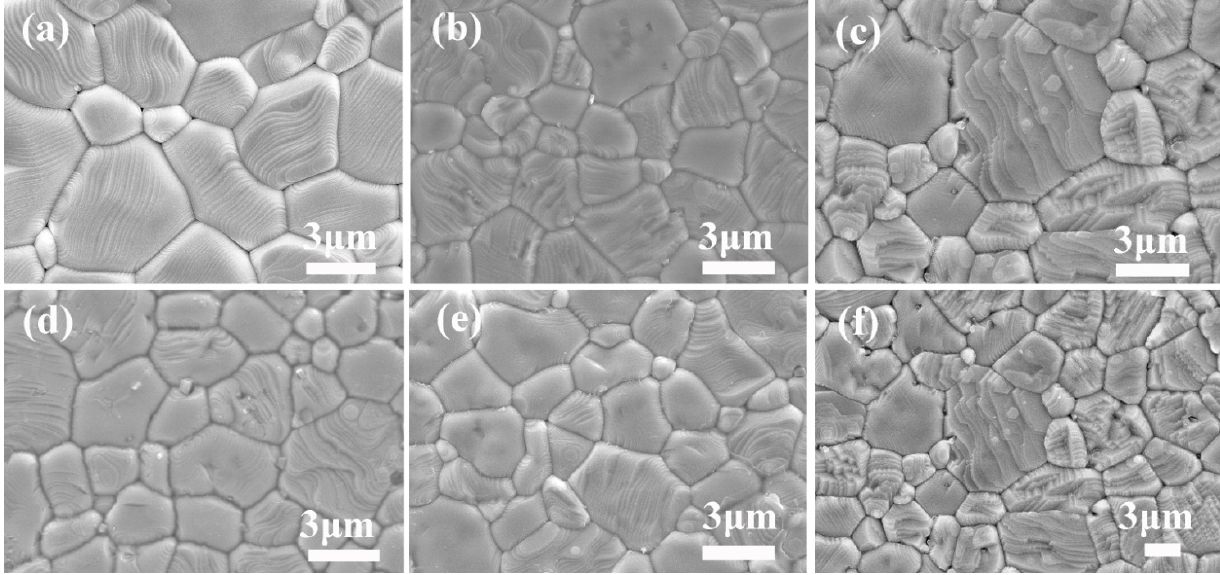
Fig. 3 SEM images of the CTLA ceramics sintered at 1450 ℃ for 4 h: (a) x = 0.3, (b) x = 0.4, (c) x = 0.5, (d) x = 0.6, (e) x = 0.7, (f) x = 0.5.